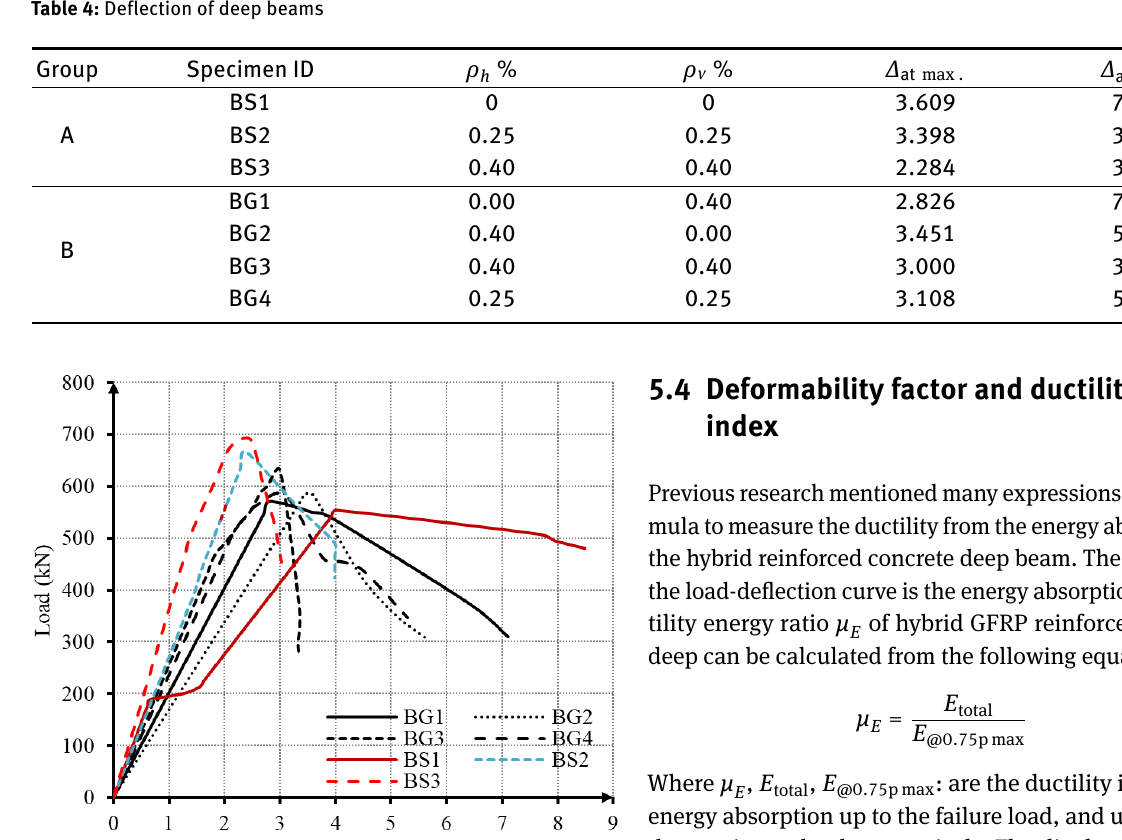
Table 4: Deflection of deep beams